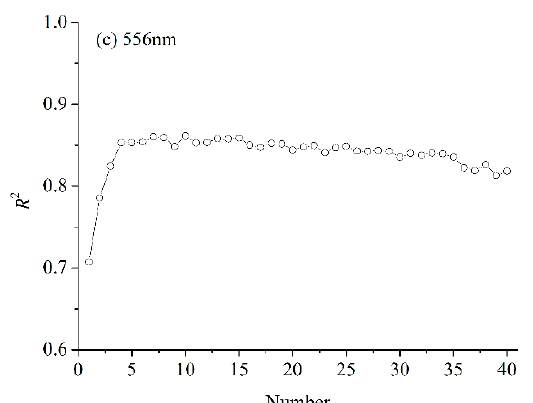
Figure 8. R 2 between the measured and predicted LNC changes with PC number based on the BPNN model at different excitation light wavelengths. ( a ) 355 nm, ( b ) 460 nm, ( c ) 556 nm.